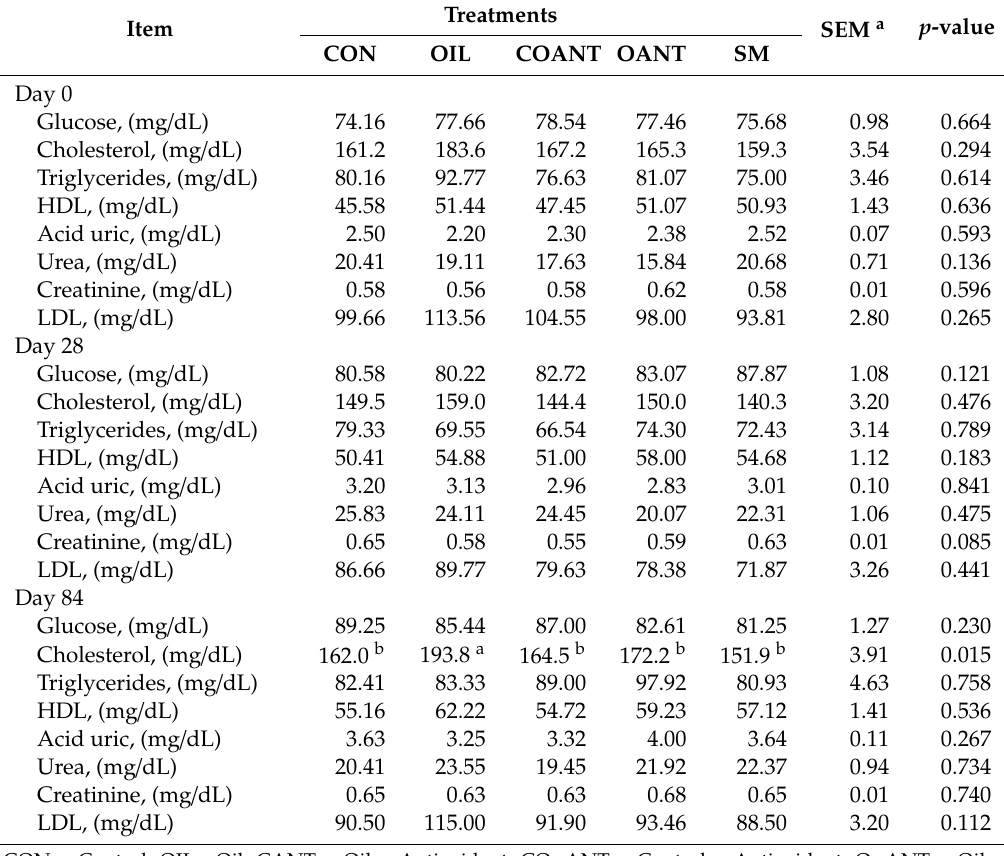
Table 4. Blood metabolites in children according to treatments and collection